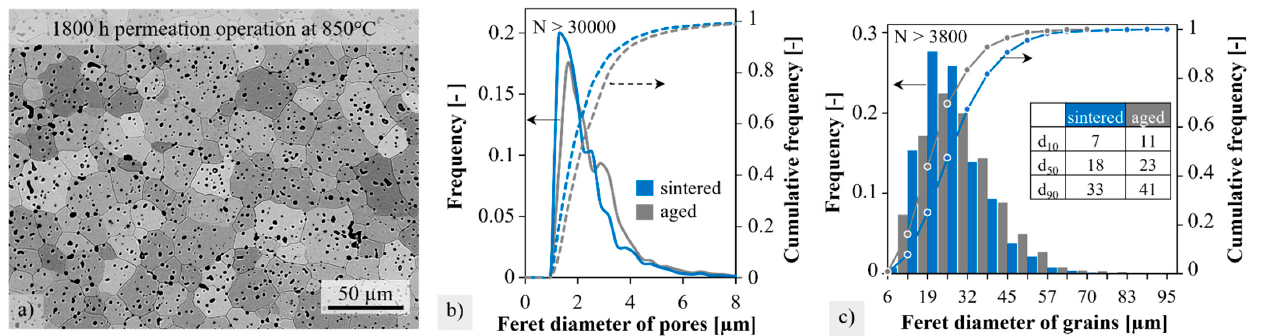
* superscript marks the number of measuring points.